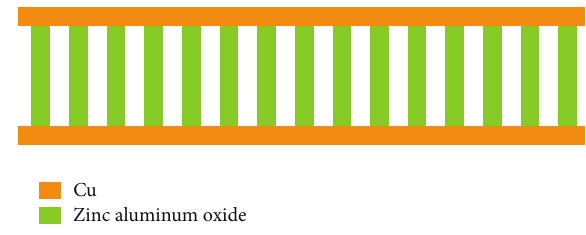
Figure 1: Schematic diagram of the prepared zinc aluminum oxide nanowire array gas sensor.